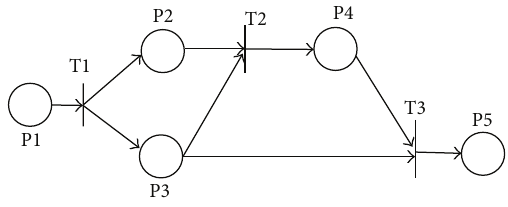
Figure 2: Graph modeling in Petri